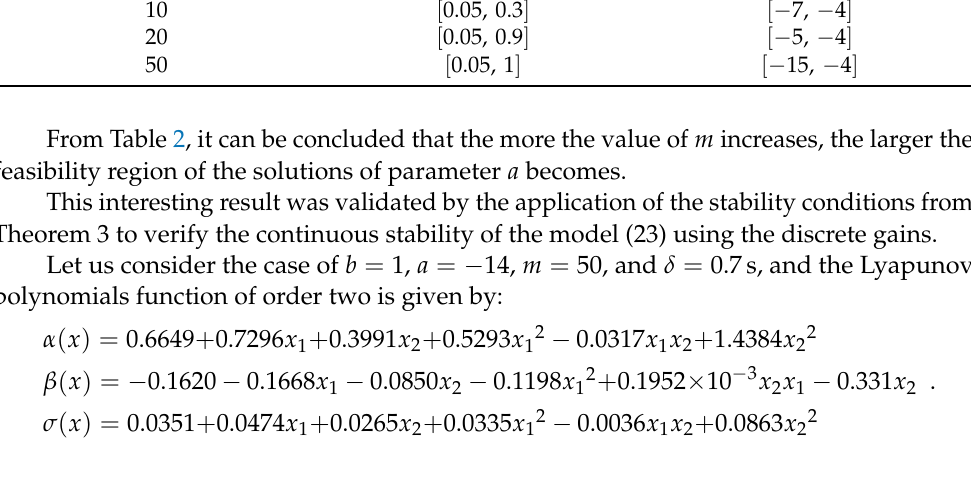
Table 2. Feasibility region of solutions of the parameter a related to m and δ .